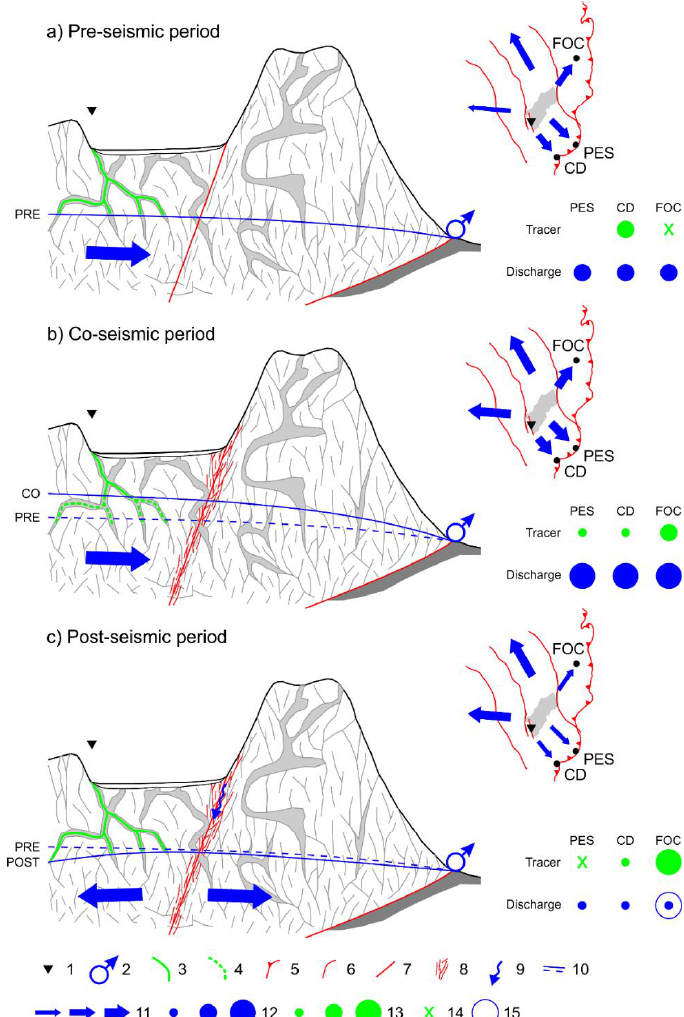
Figure 7. Schematic conceptual model. On the left, hydrogeological cross-sections (not in scale); on the right, plan views of the analyzed springs and recharge area (not in scale). In legend: (1) tracer injection point (i.e., Mèrgani sinkhole); (2) spring; (3) tracer; (4) diluted tracer; (5) thrust in plan views; (6) normal fault in plan views; (7) tectonic structures in cross-section; (8) co-seismic ruptures; (9) rainfall infiltration; (10) piezometric levels; (11) Basal aquifer main groundwater flow direction (the symbol size is proportional to the quantity: low, intermediate, high); (12) spring discharge (the symbol size is proportional to the quantity: low, intermediate, high); (13) recovered tracer (the symbol size is proportional to the quantity: low, intermediate, high); (14) tracer not recovered; (15) strong discharge response to intense rainfall events.